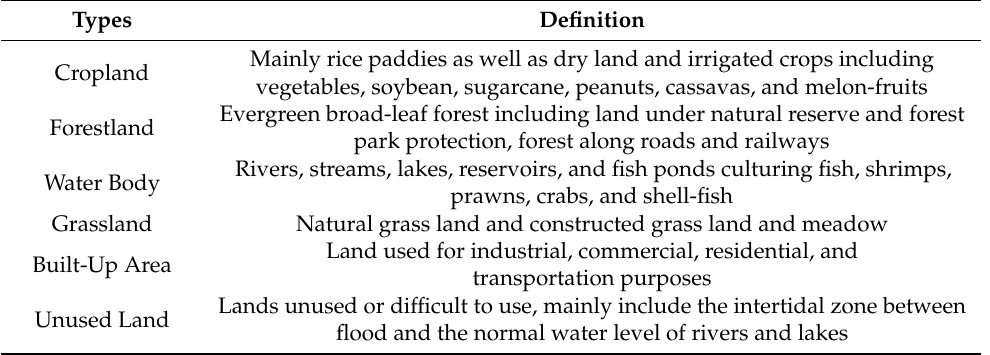
Table 1. Definition of land-use